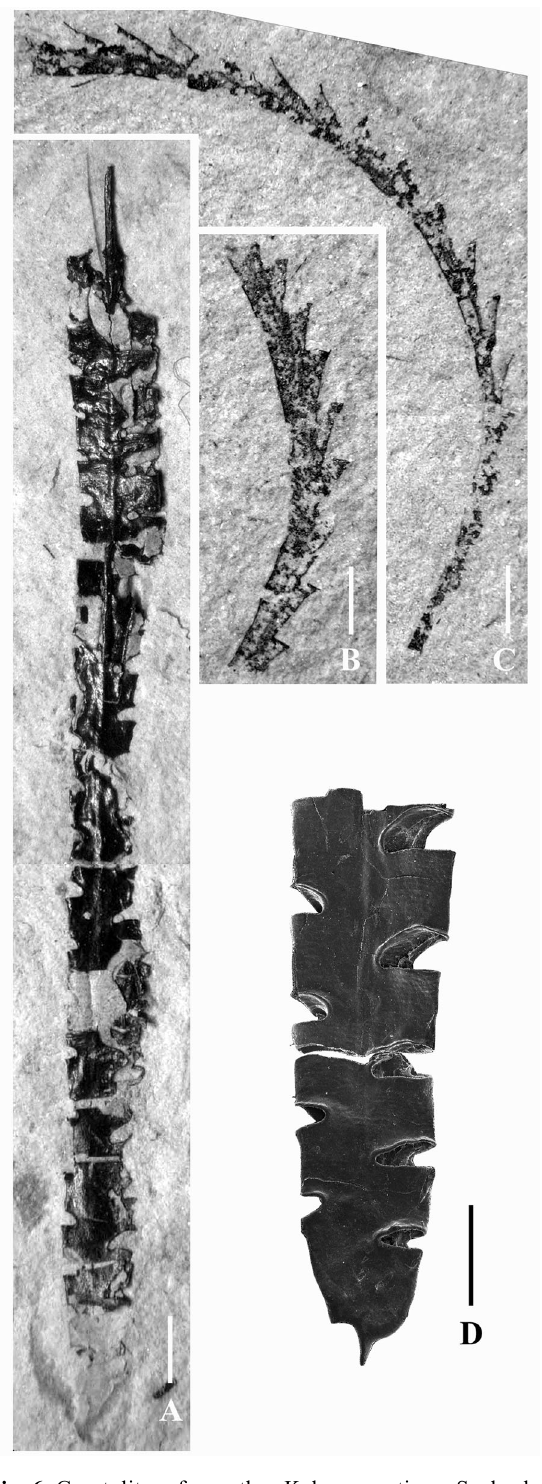
Fig. 6. Graptolites from the Kalana section. Scale bar represents 1 mm. A , Normalograptus sp. apparently showing regeneration after damages, TUG 1720-1. B , C , Coronograptus gregarius (Lapworth). TUG 1720-2 and TUG 1720-3. D , Normalograptus scalaris (Hisinger). GIT 738-24, sample